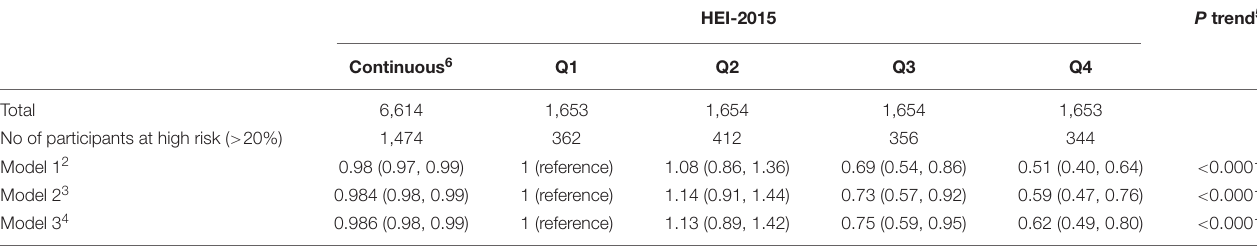
TABLE 3 | Odds ratios (OR) and 95% confidence intervals (CI) of HEI-2015 for high predicted 10-year CVD risk. 1